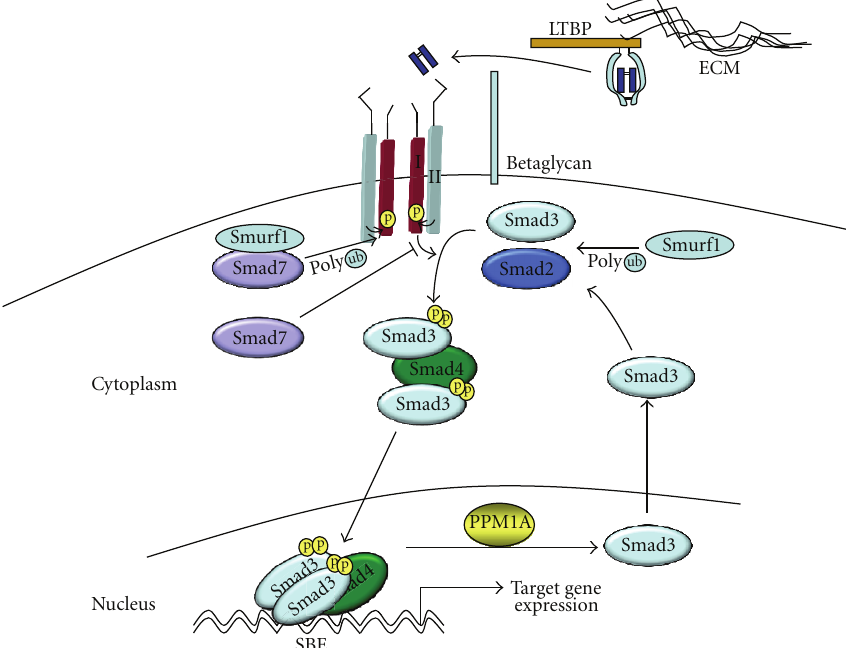
Figure 1: Schematic of TGF β 1 signaling pathway and its regulation. TGF β 1 is secreted and sequestered in the extracellular matrix as a biologically inactive complex composed of the TGF β 1 peptide linked to the latency-associated peptide (LAP) and a member of the latent TGF β -binding protein (LTBP) family. Activation of latent TGF β 1 allows binding of active peptide dimer to T β RII and formation of a heterotetrameric receptor complex Between T β RI and T β RII. Coreceptors such as betaglycan act to enhance TGF β binding to its receptors. T β RII, phosphorylates the cytoplasmic domain of T β RI and activates its serine-threonine kinase activity towards the R-Smads, Smad2, or Smad3, Phosphorylation of an R-Smad for allows complex formation with Smad4 and translocation to the nucleus, where binding to SBE target sites in gene promoters activates transcription with many other cofactors. Dephosphorylation of R-Smads by Smad phosphatases such as PPM1A attenuate signaling and cause Smads to recycle to the cytoplasm. Smad7 can block type I receptor phosphorylation of R-Smads and in conjunction with E3 ubiquitin ligases such as Smurf1 cause polyubiquitination and degradation of T β RI. Smurf1 and similar proteins have also been implicated in degradation of